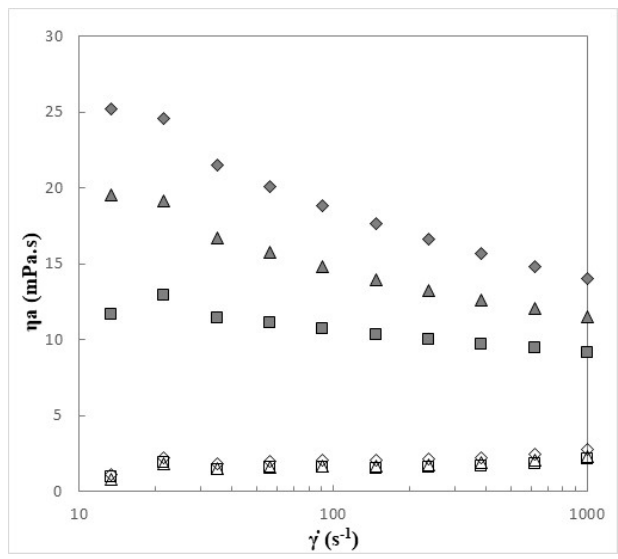
Figure 2. Apparent viscosity of first soluble fractions of CGC1 ( (cid:4) ), CGC2 ( (cid:78) ) and CGC3 ( ), and solvent systems 1 ( (cid:3) ), 2 ( (cid:52) ) and 3 ( ), measured at 20 °C.